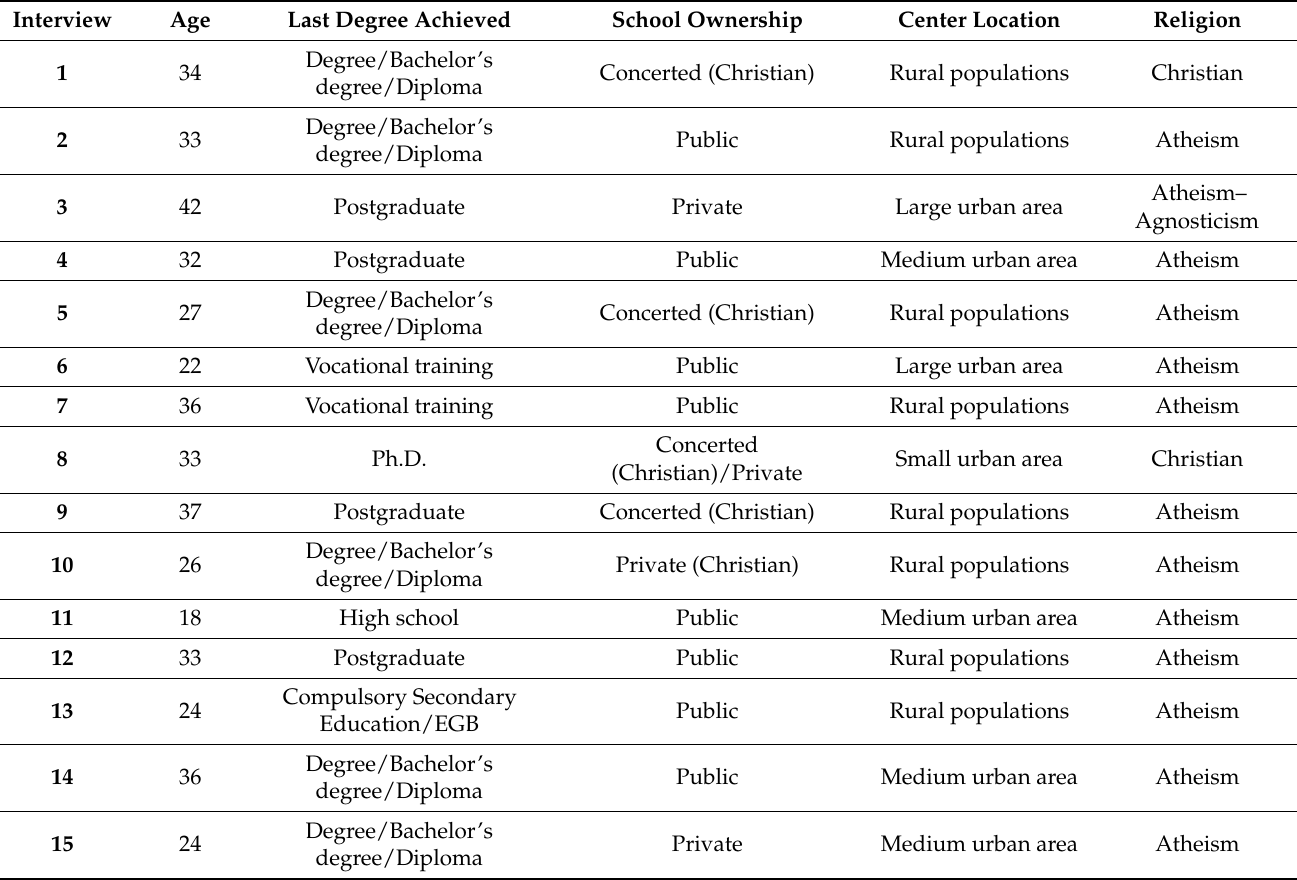
Table 2. Sociodemographic